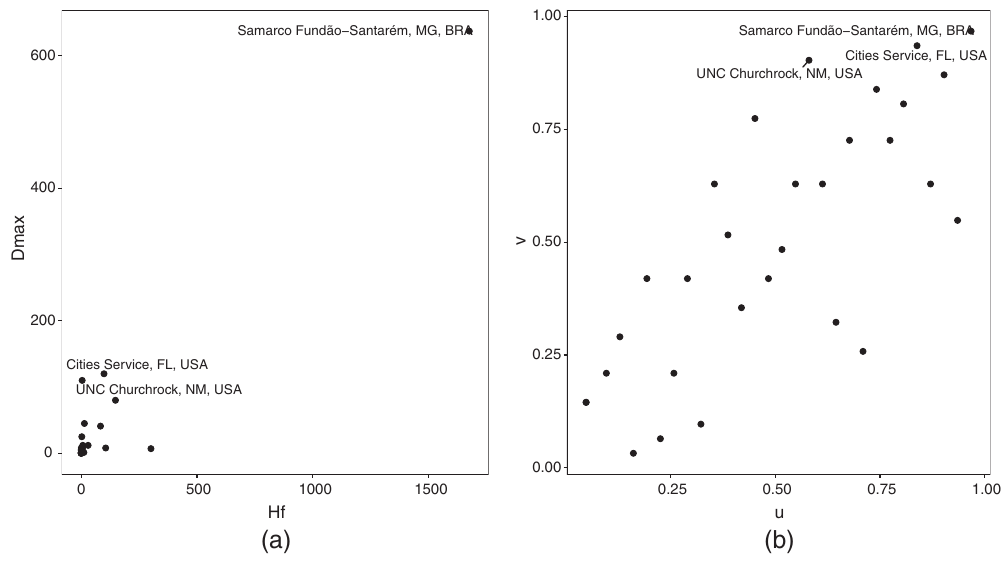
Figure 3. Scatterplot for H f vs. D max with (a) original observations and (b) observations transformed to [0, 1] by scaling ranks, U vs. V . H in meters (m), D max in kilometres